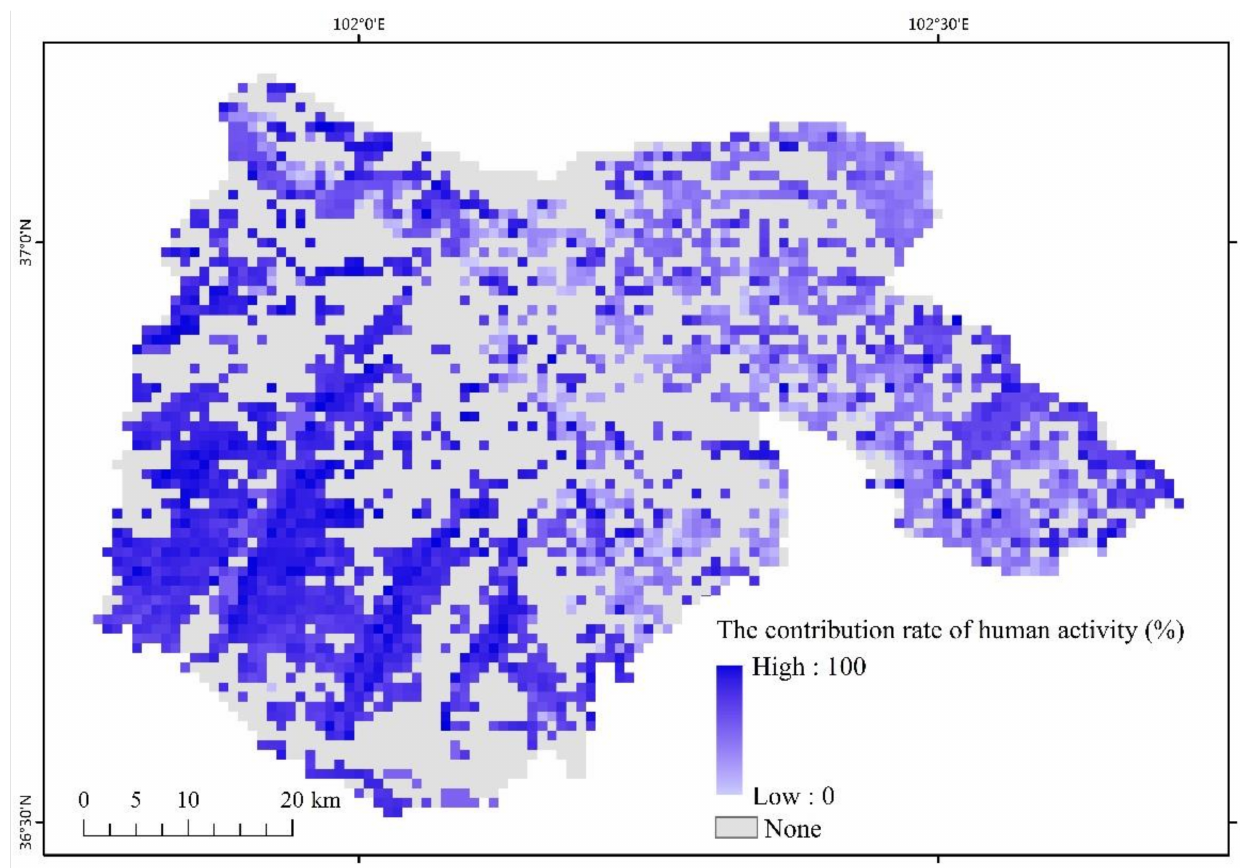
Figure 7. Contribution rate of human activity to ecosystem NPP changes during the assessment period. Gray areas marked with “None” mean that trends in actual and potential NPP were all insignificant, which were not involved in the assessment of